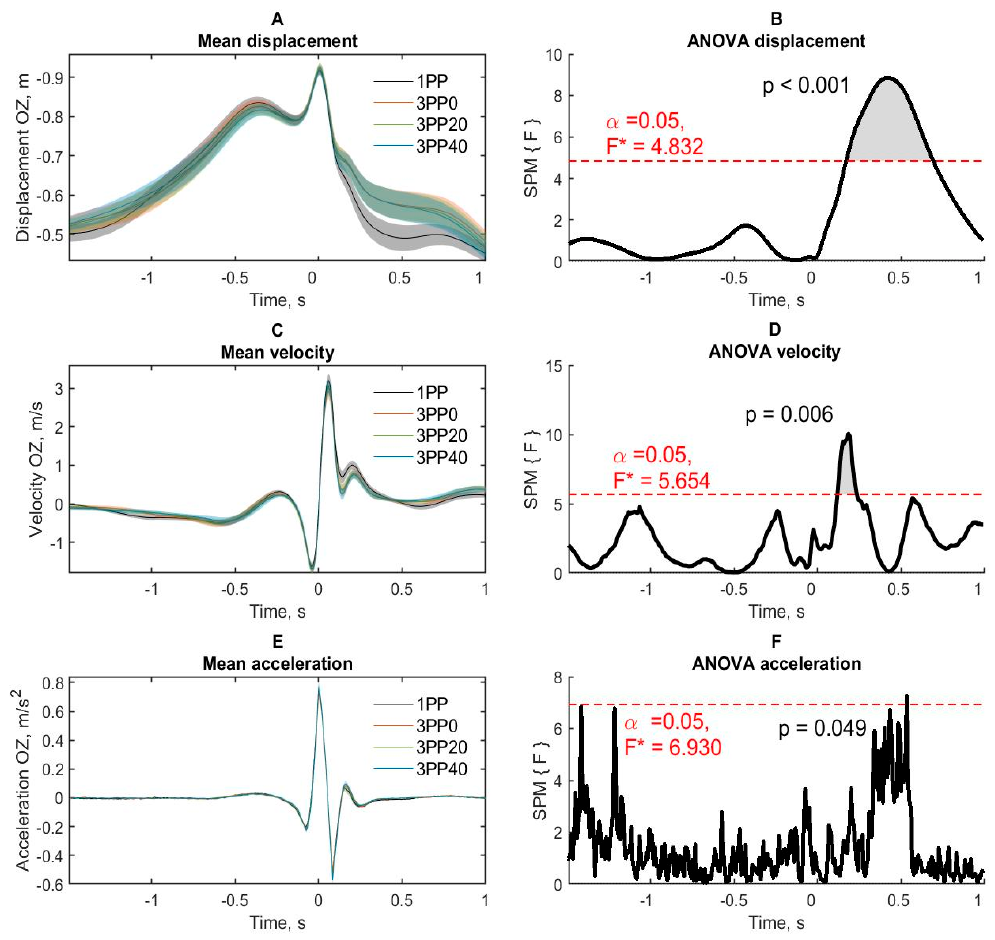
Figure 5. The right hand kinematic data along the OZ axis. A, C, E. Displacement, velocity and acceleration of the right hand in four conditions of throws. Semi-transparent areas around lines are standard error of mean. B, D, F. ANOVA effects of the condition. Red dashed lines denote the statistically significant level (with FWER correction). 1PP—first person condition, 3PP0—third-person perspectives with 0°, 3PP20—third-person perspective with 20° and 3PP40—third-person perspective with 40°. Time 0 represents the moment of peak velocity of the right hand moving along the OY axis (along the direction of the throw).